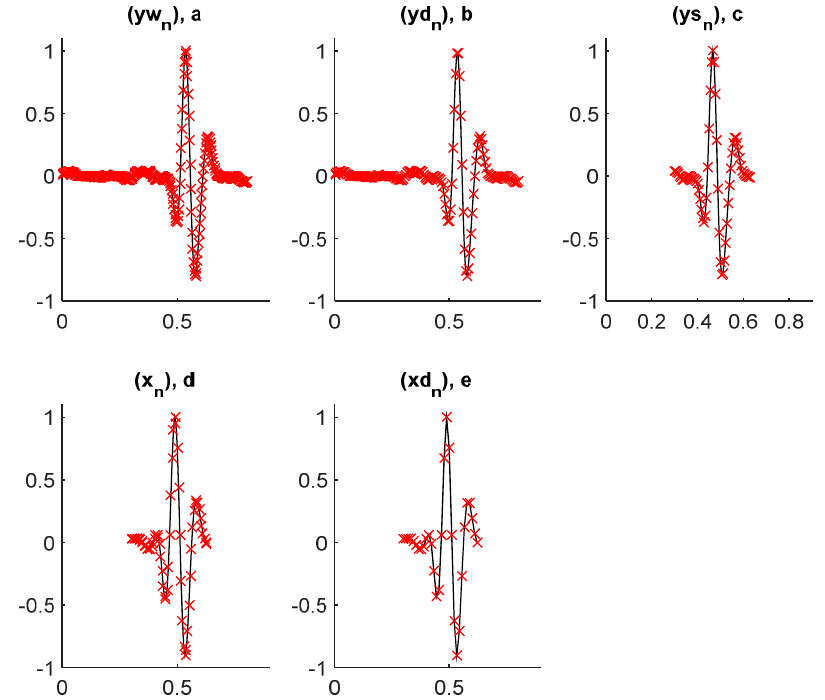
Figure 8. Different front-end processing stages on a RBBB heartbeat, where the y -axis is the nor- malized amplitude and x -axis is the time in seconds ( a ) an example of the windowed signal yw n ; ( b ) the subsampled signal yd n ; ( c ) ys n obtained after the segmentation of QRS complex from yd n ; ( d ) denoised signal x n ; ( e ) xd n obtain after x n is subsampled with a factor of 2.